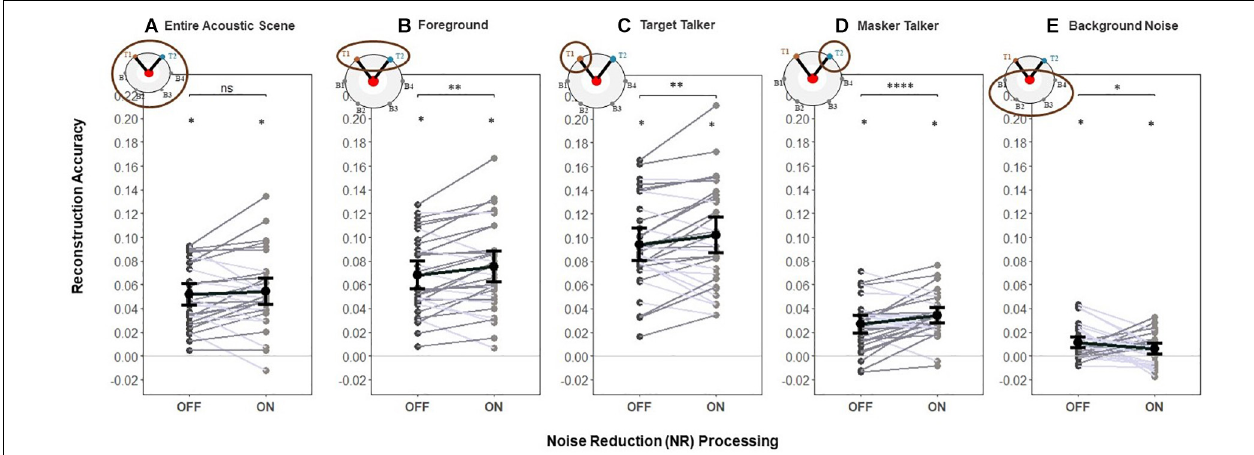
FIGURE 5 | Reconstruction accuracy for late responses (85–500 ms). (H2-H3) The target talker is represented with significantly higher fidelity than masker talkers in late EEG responses. The NR scheme enhances the representation of the foreground and individual (target and masker) talkers in the front hemifield (i.e., higher reconstruction accuracy) and suppresses the representation of the background noise (i.e., reduced reconstruction accuracy) in late EEG responses. A significant main effect of attention, indicating selective cortical representations of the target envelope in the late EEG responses, was observed. A significant main effect of NR scheme setting on reconstruction accuracy was observed, indicating the enhanced cortical representations of the target, masker, and foreground envelopes and the reduced representation of the background noise envelope in the late EEG responses when NR scheme was active. Gray dots indicate trial-averaged individual reconstruction accuracy results, whereas black dots and error bars show the group (grand-average ± 1 between subject SEM) reconstruction accuracy results using decoders trained only on (A) entire acoustic scene envelope (entire acoustic scene decoder) or (B) foreground envelope (foreground decoder) or (C) target envelope (target decoder) or (D) masker envelope (masker decoder) or (E) background noise envelope (background noise decoder). Each horizontal line in gray denotes single participant (dark gray denotes enhanced cortical representation and light gray denotes reduced cortical representation when activating NR scheme) and each horizontal line in black denotes average reconstruction accuracy across participants for each envelope type. The asterisk above each condition indicates reconstruction performance significantly greater than zero (determined with a two-sided t -test with criterion p = 0 . 05). The asterisk above the bars indicates significant differences between the noise conditions (* p = 0 . 05, ** p = 0.01, and **** p =